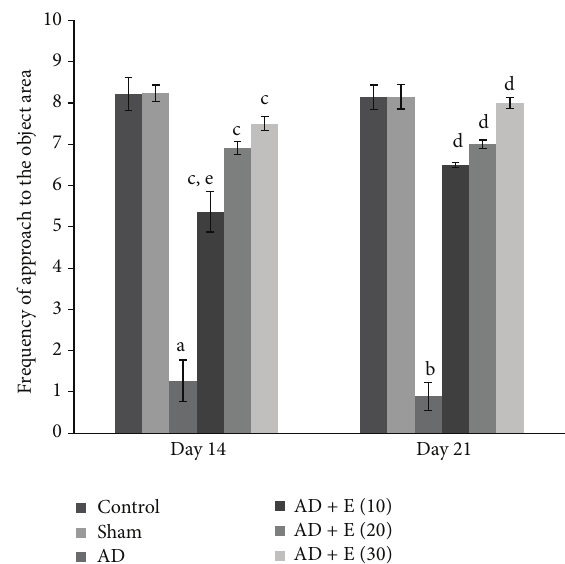
Figure5:Thefrequencyofapproachtotheobjectareainanelevated open space with a novel object (for anxiety status) of different experimental groups of rats. a cAD versus control/sham operated rats at day 14 ( 𝑝 < 0.001 ). b cAD versus control/sham operated rats at day 21 ( 𝑝 < 0.001 ). c cAD versus etoricoxib treated cAD at all the doses at day 14 ( 𝑝 < 0.001 ), d cAD versus etoricoxib treated cAD at all the doses at day 21 ( 𝑝 < 0.001 ), and e 10 mg/kg body weight etoricoxib administered cAD versus 30 mg/kg body weight etoricoxib administered cAD at day 14 ( 𝑝 < 0.001 ). Abbreviations are the same as in Figure 1. Values are expressed in mean ± SEM ( 𝑛 = 6 in each group).